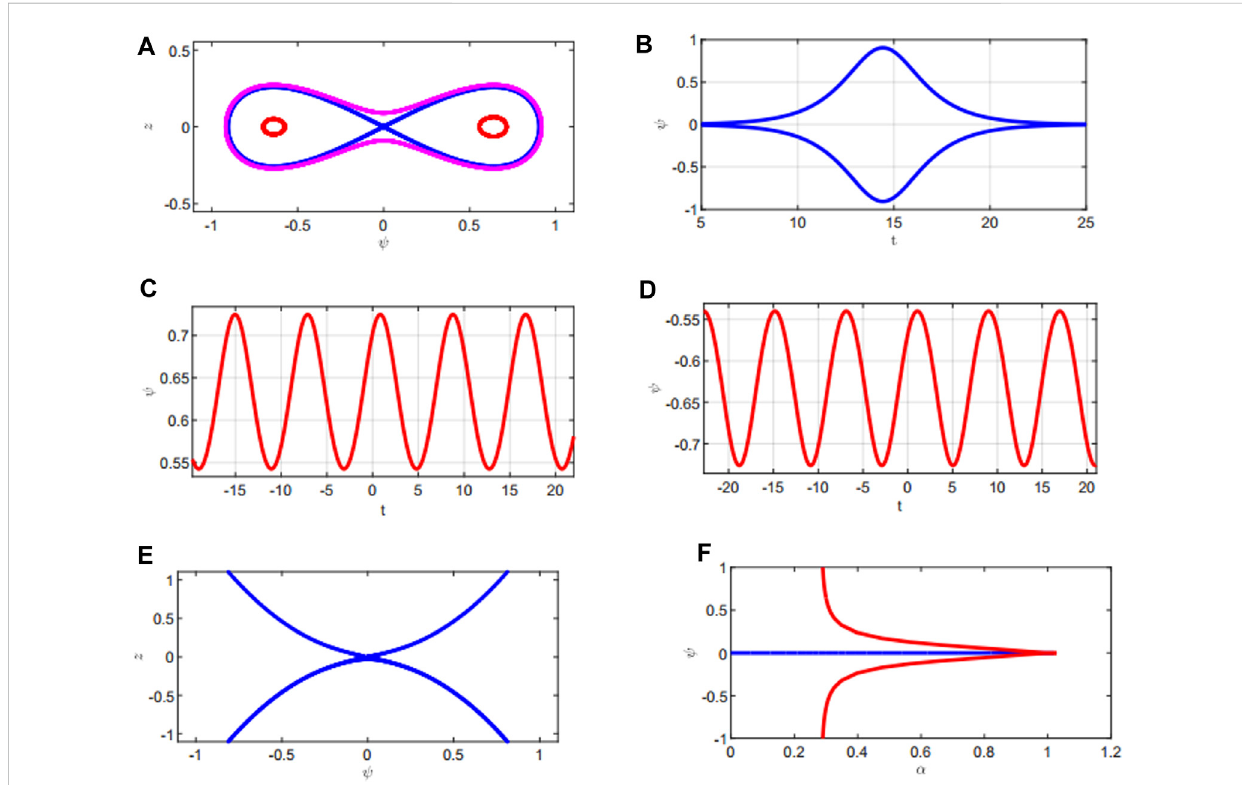
FIGURE 8 (A) Phase plane diagram in the ( ψ , z ) plane for α =0.3 and A > 0. (B) Solitary wave. (C) – (D) Periodic wave for α =0.3 and A > 0. (E) Phase plane diagram in the ( ψ , z ) plane for α =0.1 and A < 0. (F) Bifurcation diagram between α and ψ keeping other parameters as β =0.026, δ =0.01, γ =0.7, ] =0.9, and μ